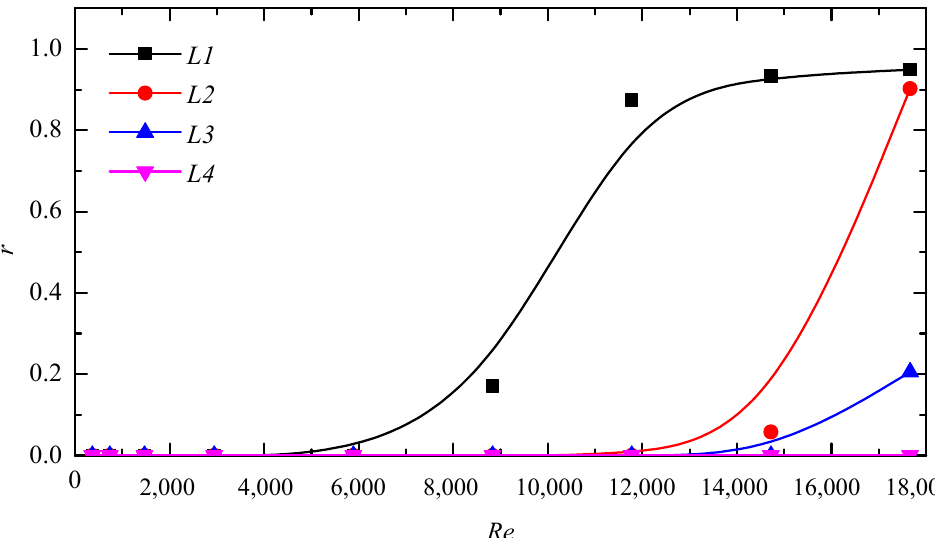
Figure 18. Numerical results of droplet re-entrainment ratio r versus Reynolds number with different wavelength. Table 4. Correlation results in separation efficiency under different wavelengths L .